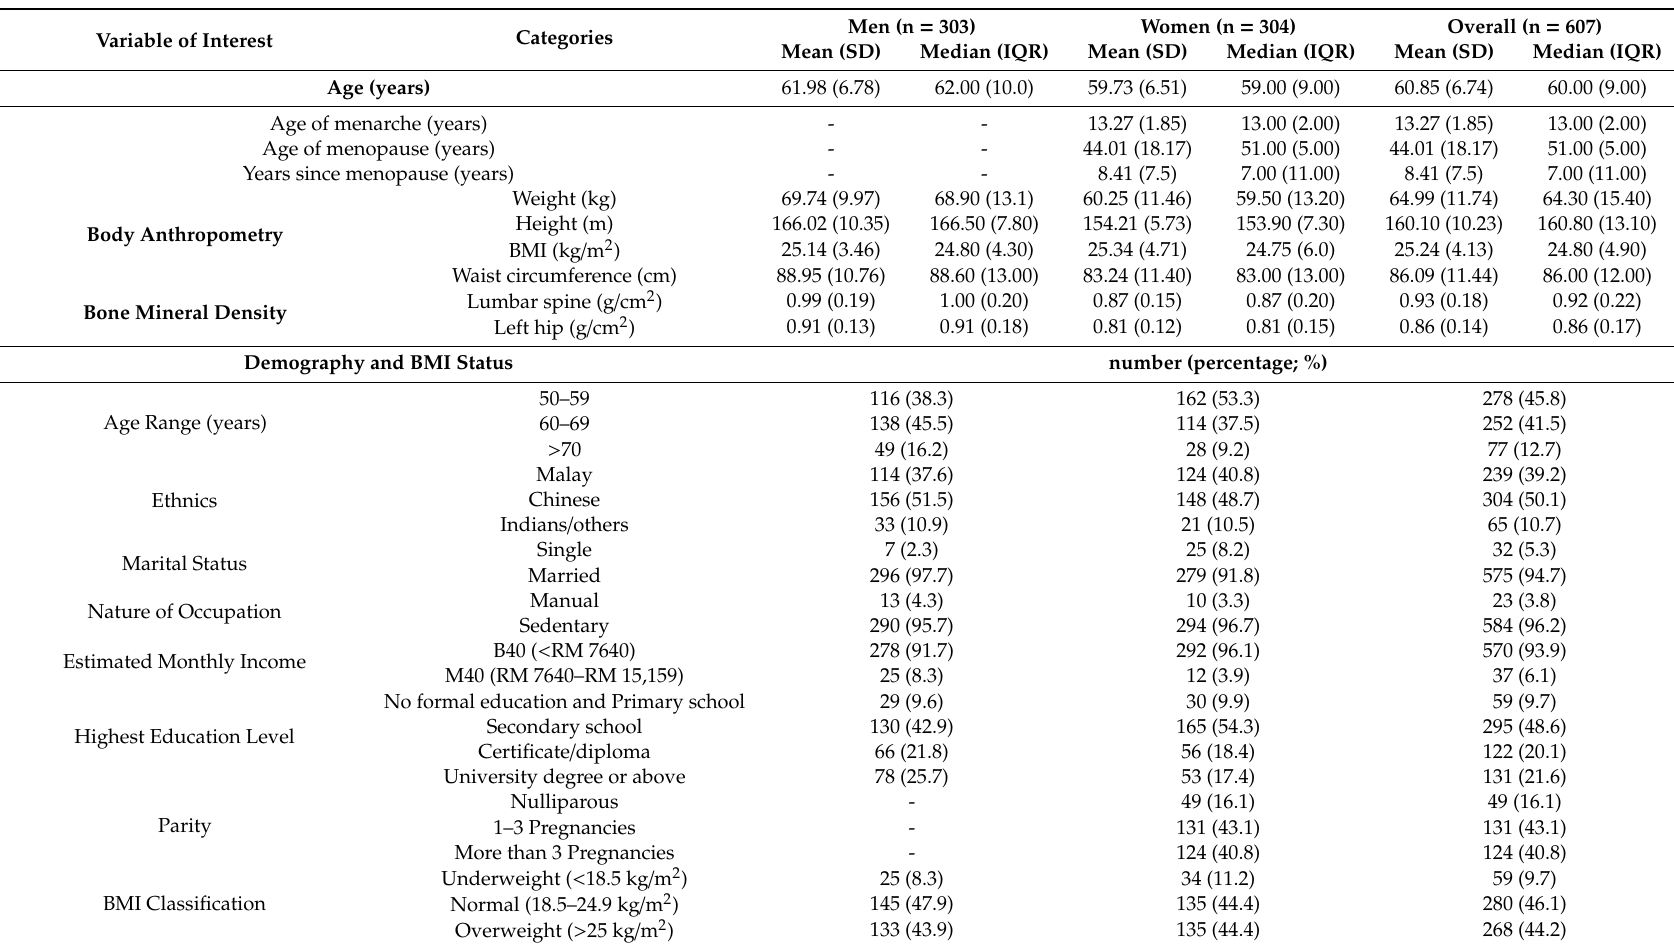
Table 2. Characteristics of the study